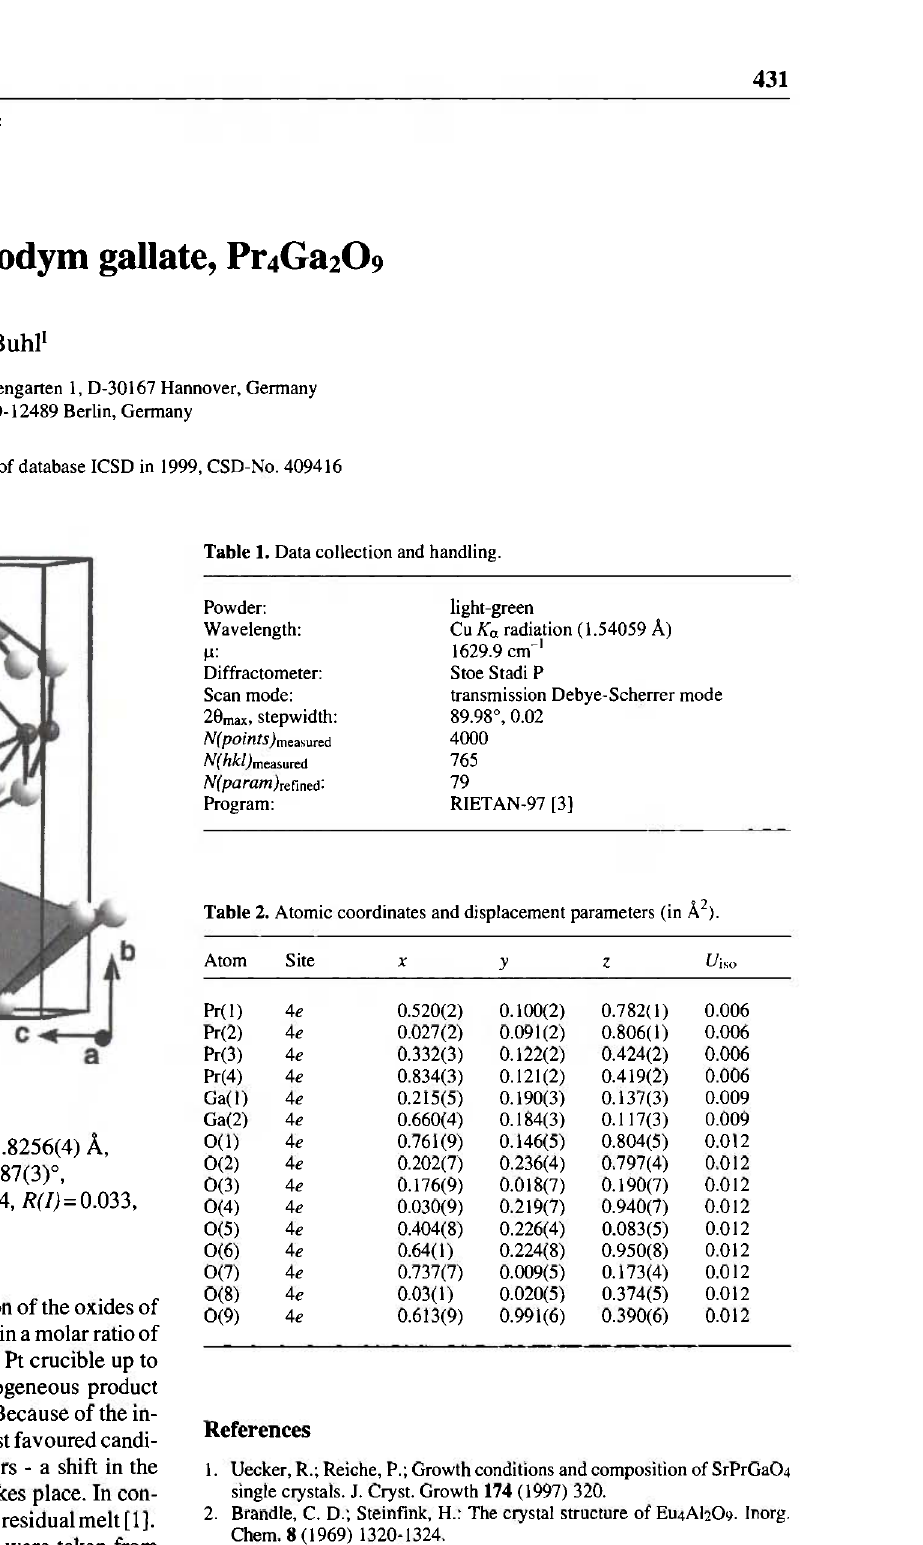
Table 1. Data collection and handling.